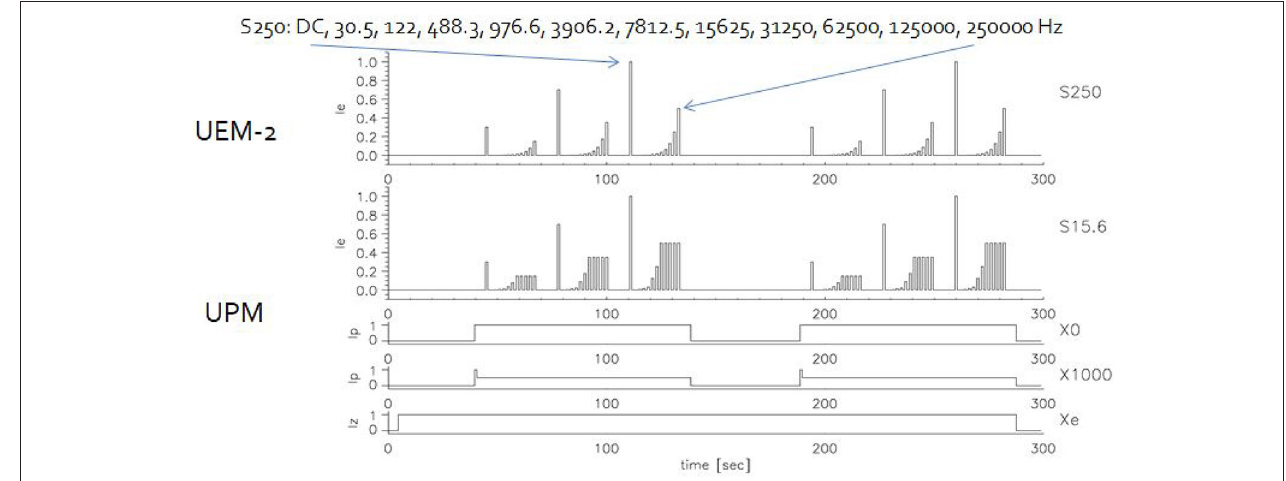
FIGURE 4 | Mean injection current profiles for different beam modulation modes of the UEM–2 and UPM injectors. Top two panels—UEM–2 modes S250 and S15.6; bottom three panels—UPM DC mode F0, modulated mode F1000, and neutral xenon gas release. (Adapted from Prech,